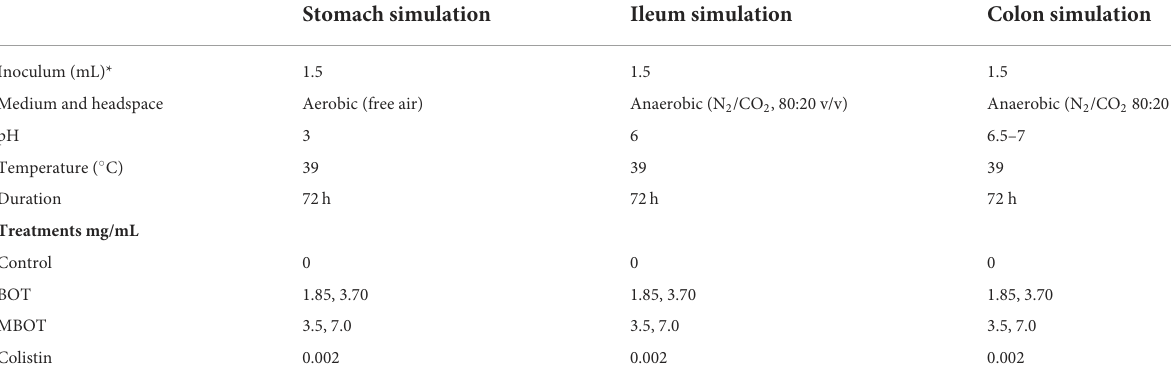
TABLE 1 In vitro batch incubation conditions simulating the pig gastric, ileal, and colonic fermentation. Stomach simulation Ileum simulation Colon